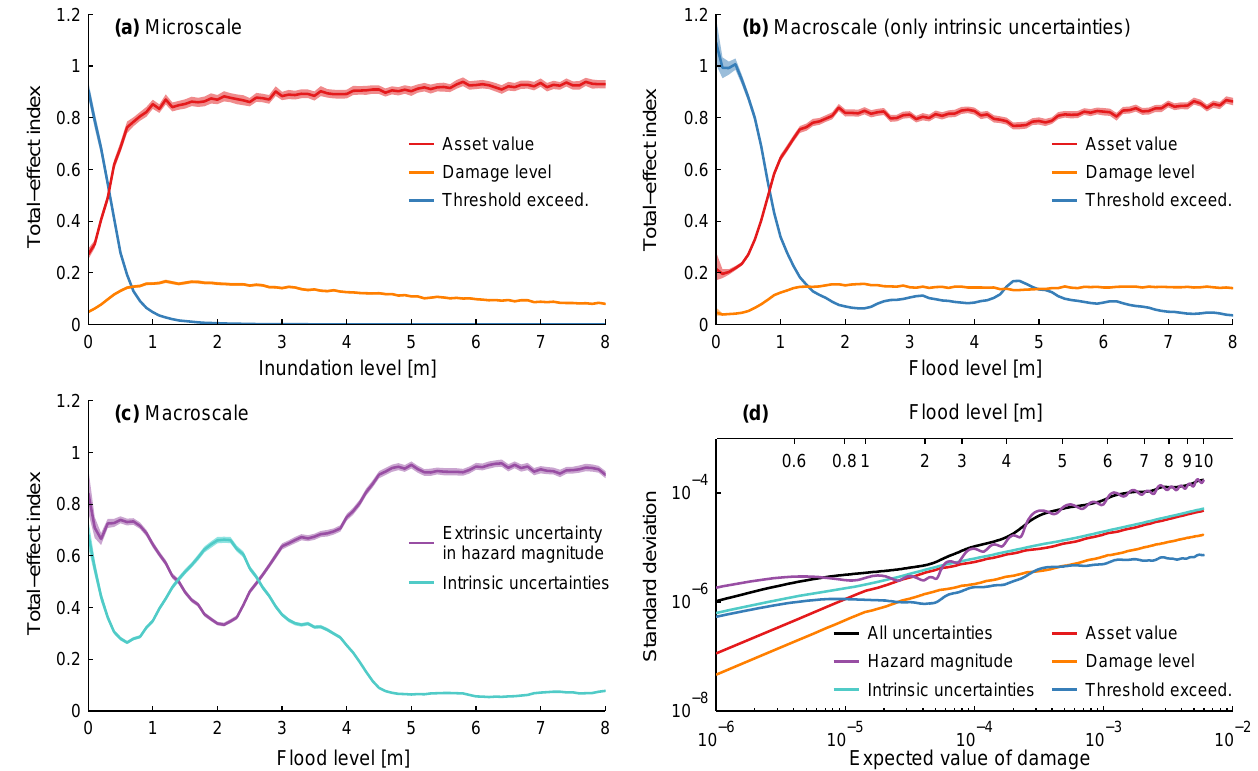
Figure 6. (a–c) show the results of variance-based sensitivity analysis (total-effect index) for the Lisbon case study at different scales. Shaded areas indicate boot-strapped confidence bands. For microscale damages, (a) shows the attributable effect of intrinsic uncertainty in asset value, damage, and threshold exceedance on the total variance. Similarly, (b) shows the effect of the intrinsic uncertainties on the variance of the aggregated portfolio. In (c) , the portfolio-aggregated microscale uncertainties are weighed against the hazard uncertainty, i.e. error in estimated flood level. (d) shows the standard deviation against the expected value of flood damages on log–log scale. Each curve includes the uncertainty sources indicated by the